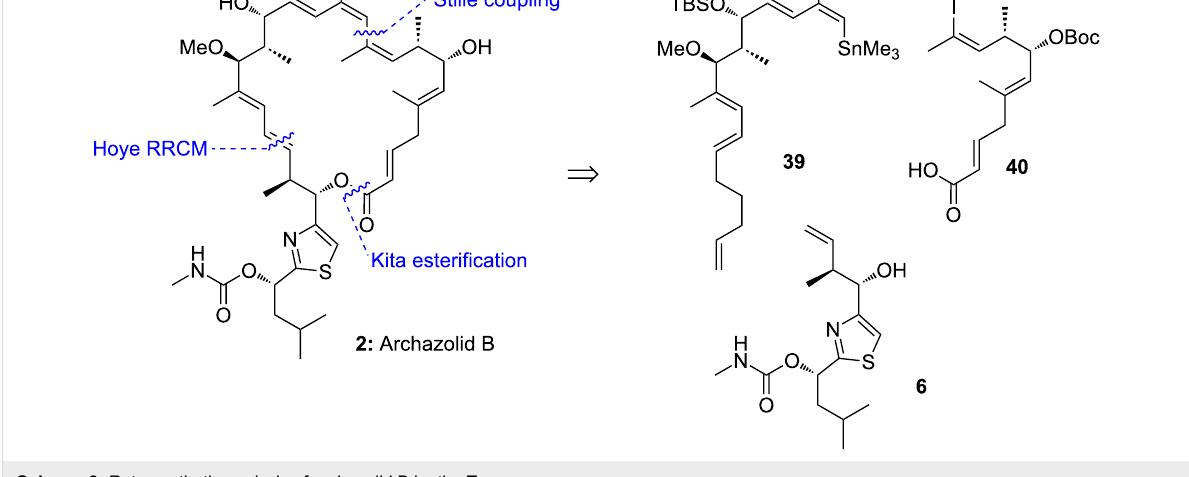
Scheme 8: Retrosynthetic analysis of archazolid B by the Trauner